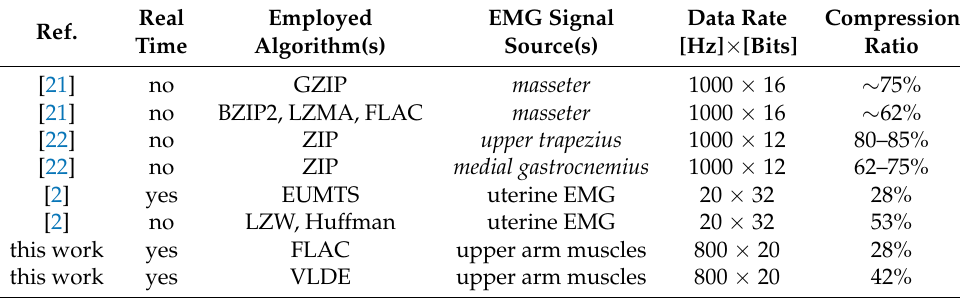
Table 5. Performance comparison with other